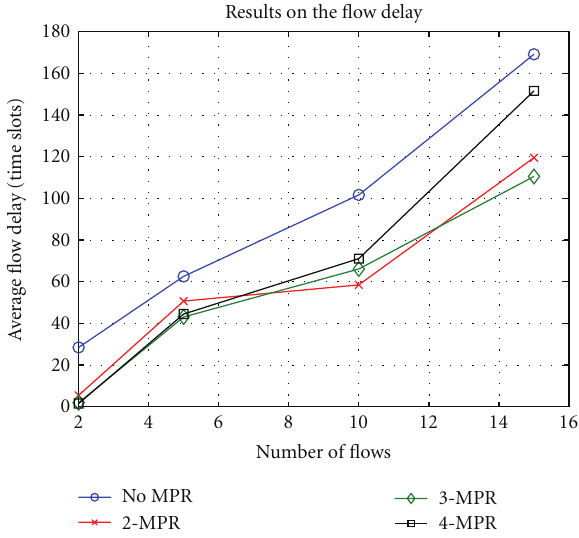
Figure 12: The delay increases with the number of flows.